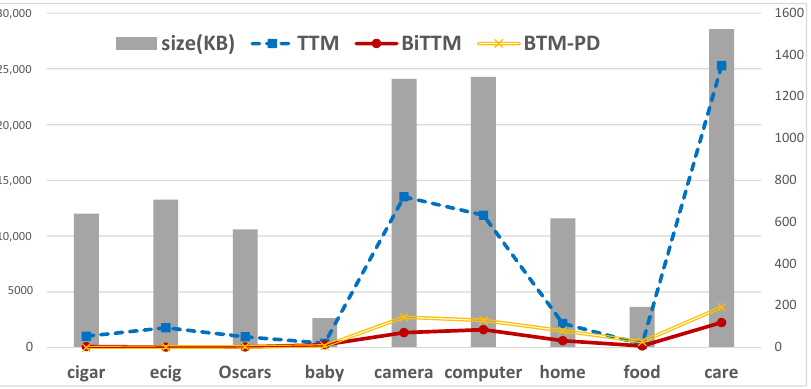
Figure 5. Time cost in datasets of different